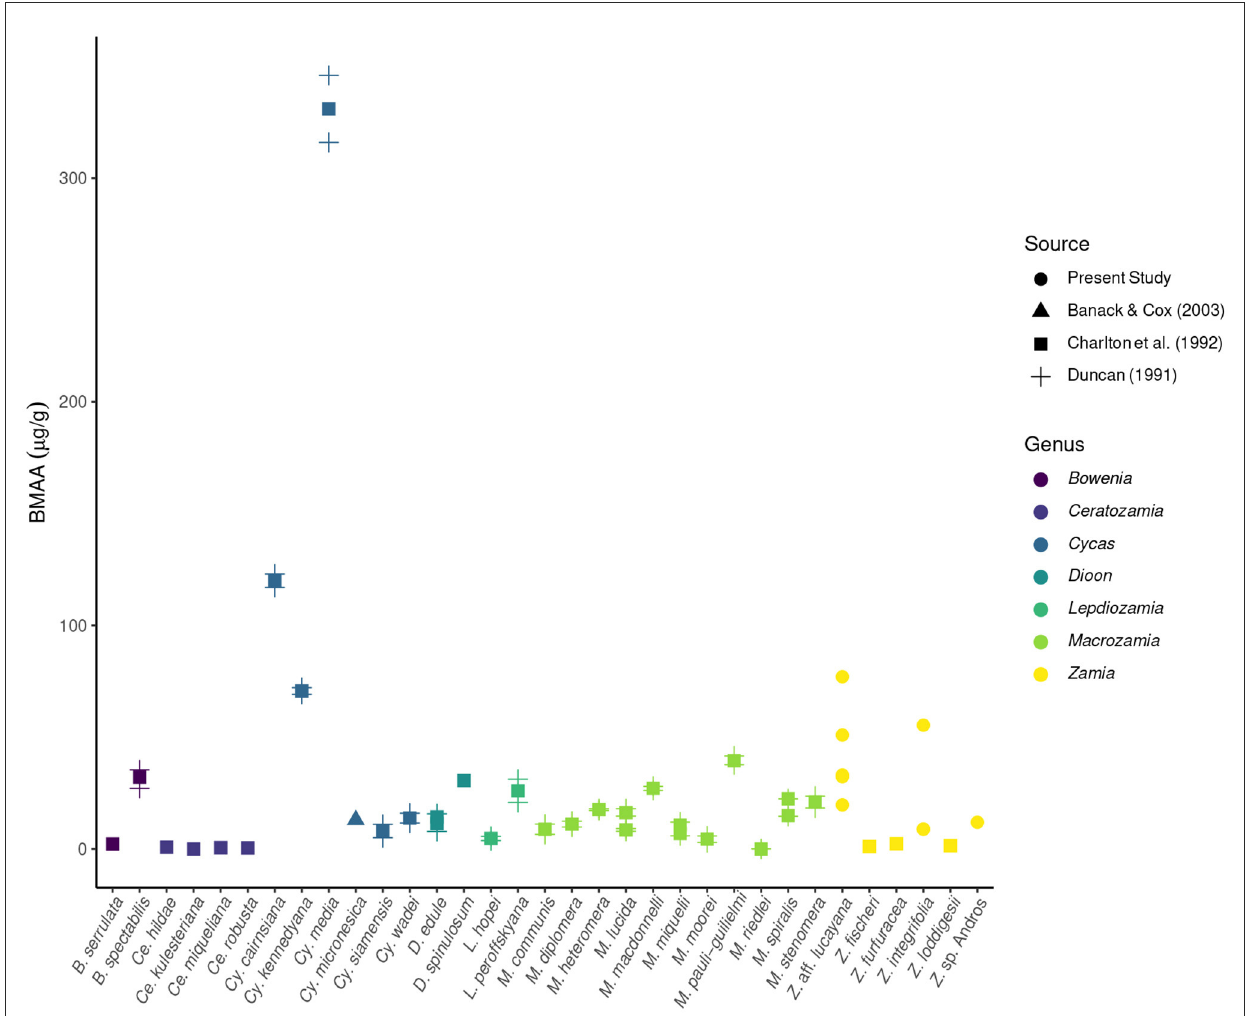
FIGURE1 Foliar BMAA concentrations across cycad species, based on data from the present study as well as three previously published studies. Both Duncan et al. (1990) and Charlton et al. (1992) detected BMAA in much higher amounts ( > 1,300 µ g/g) in a species they call Cycas circinalis , but due to taxonomic uncertainty associated with this species epithet, those data are excluded here. Measurements from the present study fall within the range of previously reported